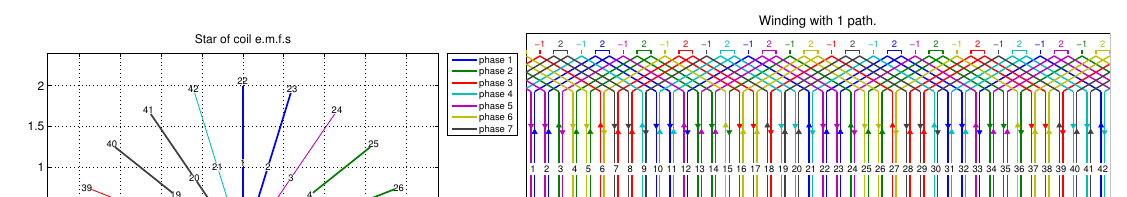
(ph1: blue, ph2: red, ph3: green).